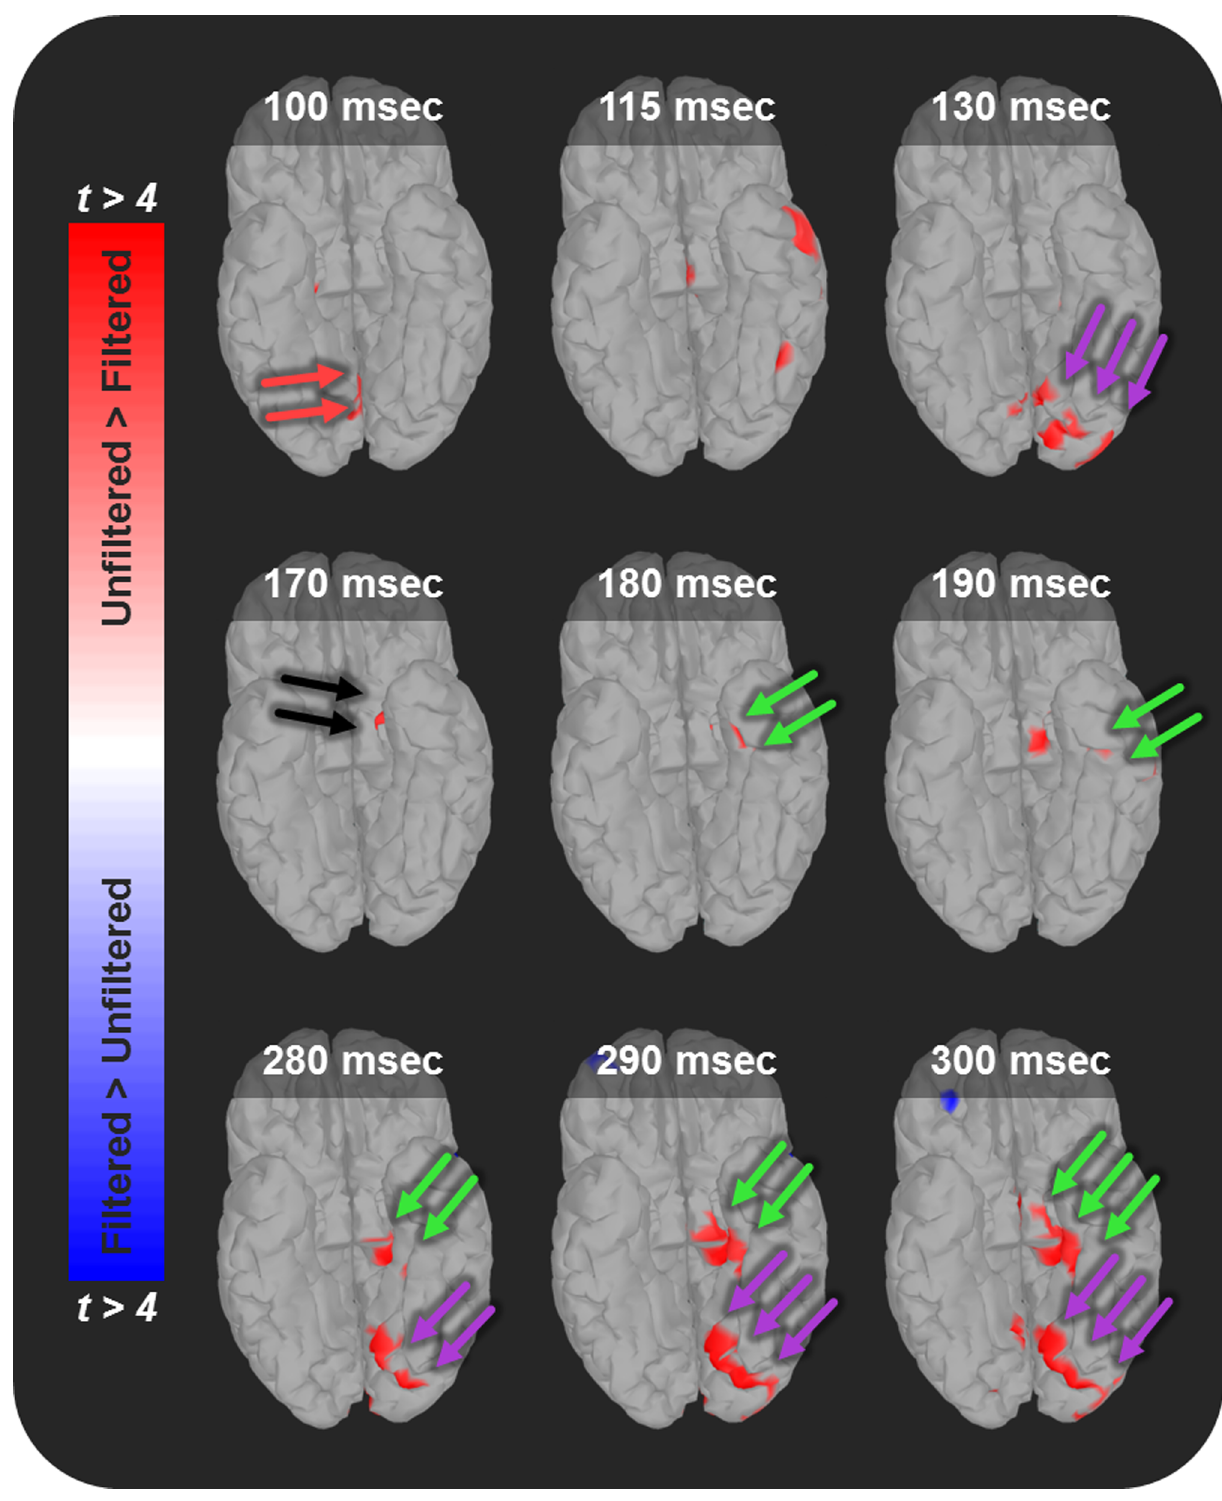
Figure 2. Unfiltered faces evoke larger responses than filtered faces in a network of brain regions important for face perception. Early responses to unfiltered faces seem to be predominantly in occipital regions. Amygdala activity emerges at approximately 170 msec. Activity at later timepoints seems to occur in medial temporal lobe, and occipital regions. Colors represent the magnitude of the Unfiltered . Filtered t-test at the corresponding dipole. Warm colors represent larger responses to unfiltered faces than to filtered faces. Cool colors represent larger responses to filtered faces than to unfiltered faces. Arrows highlight regions of interest discussed in text (red=V1; purple=occipital face area/lingual gyrus; black=amygdala; green=medial temporal lobe).